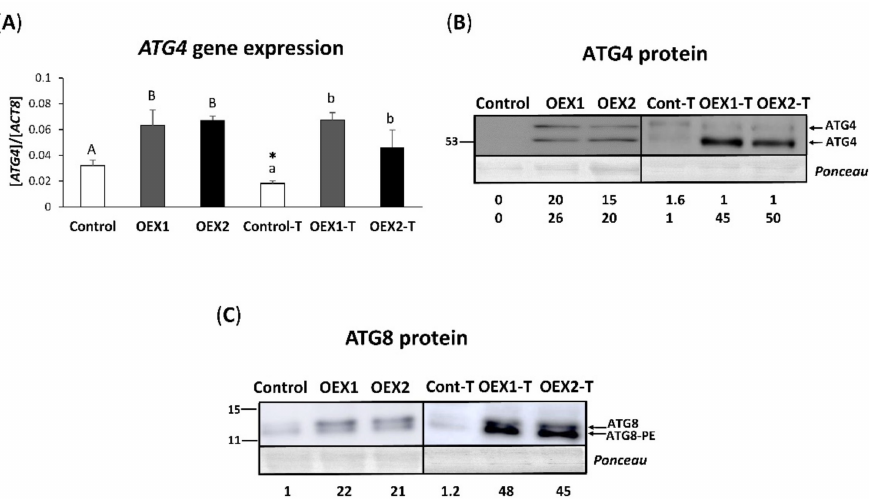
Figure 2. ATG4 ( A ) gene expression and ATG4 ( B ) and ATG8 ( C ) protein content in control and two overexpressing Pstrxo1 (OEX) TBY-2 lines at day 6 of growth (left panel) and 24 h after 35 mM H 2 O 2 treatment (treated cells (-T), right panel). ( A ) mRNA level was determined by real-time qPCR. Values are expressed as relative expression against the NtActin8 (ACT8) gene. Bars show means ± standard error of three independent experiments with three biological replicates in each one and three technical replicates. Different letters indicate significant differences ( p < 0.05) between genotypes in each condition according to Tukey’s test, and the asterisks indicate significant differences for each genotype after the H 2 O 2 treatment compared with the non-treated cells, as determined by Student’s t -test ( p < 0.05). ( B , C ) Representative Western blot of ATG4 and ATG8 protein of cellular extracts separated by SDS–PAGE and visualized by chemiluminescence, pointing to the non-lipidated and lipidated (PE) forms of the protein. Pounceau staining of the membrane was used to correct the loading. Values under figures are the mean of three experiments quantified after densitometry (numbers below show the sum of both forms for ATG8 while each band for ATG4) and refer to the lowest band intensity whose value is 1.